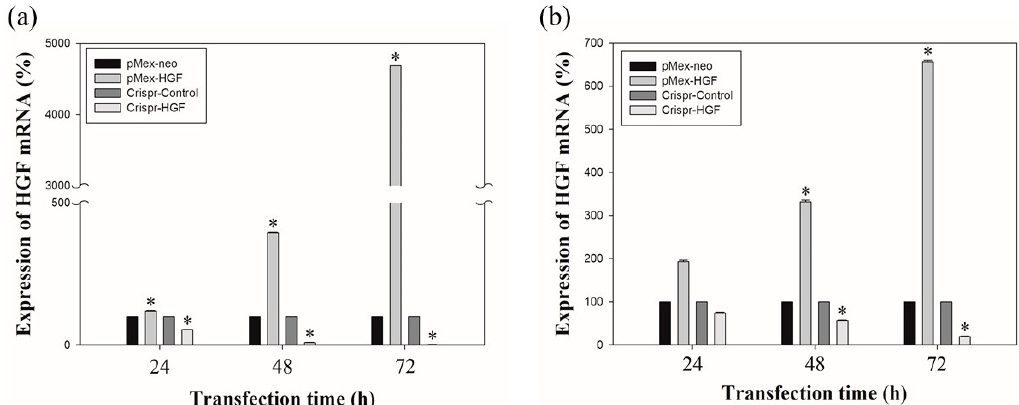
Figure 2. The mRNA expression levels of HGF as measured by qRT-PCR. Huh7 and Hep3B cells were transfected with the pMex-neo or pMex-HGF, and Crispr-Control or Crispr-HGF plasmid. Total mRNA was isolated from the cells 24, 48, and 72 h after transfection. ( a ) HGF mRNA increased in pMex-HGF-transfected cells, however, decreased in Crispr-HGF-transfected Huh7 cells. ( b ) In same condition, we also determine HGF mRNA increased in pMex-HGF-transfected cells, however, decreased in Crispr-HGF-transfected Hep3B cells. Error bar represents the mean ± SEM. * p < 0.05. These assays were performed at least three times in triplicate.